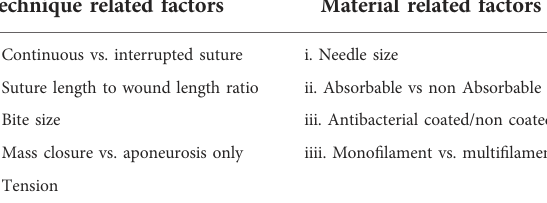
TABLE 2 Surgical technique related